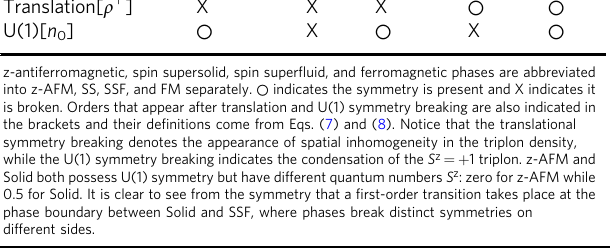
Table 1 The symmetry table for each phase.